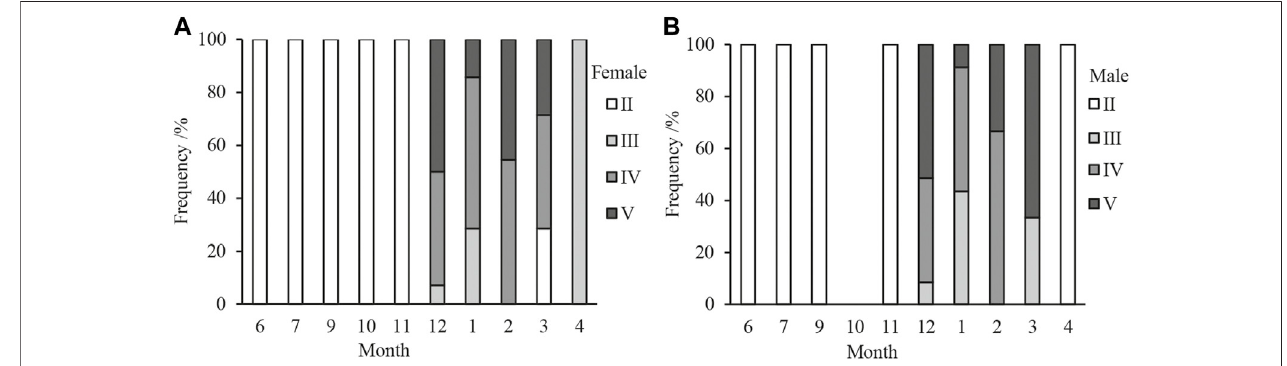
FIGURE 3 | Monthly variations in gonad stages denoting males and females of the Acanthopagrus schlegelii sampled from Zhanjiang estuary waters. (A,B) represented the males and females respectively.